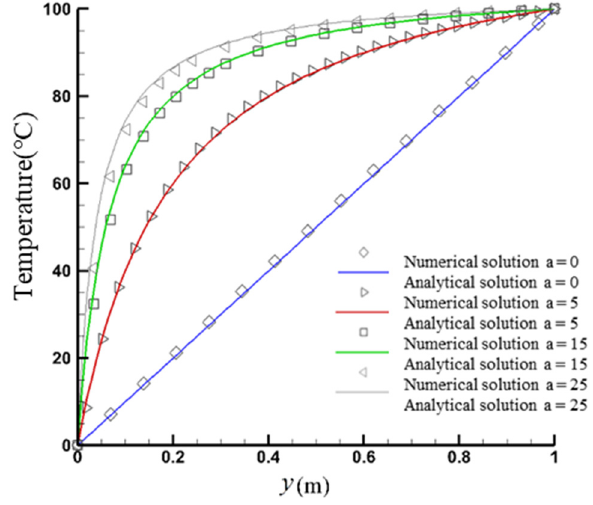
Figure 8. Numerical and analytical solutions along the y direction for the steady-state heat conduction with different gradient coefficients under the square distribution.